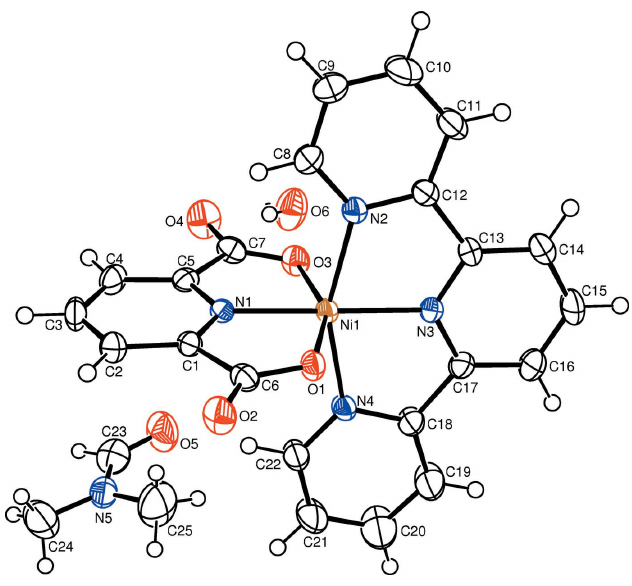
Figure 1 The molecular structure of the title compound showing the atom labelling and displacement ellipsoids drawn at the 50% probability level for non-H